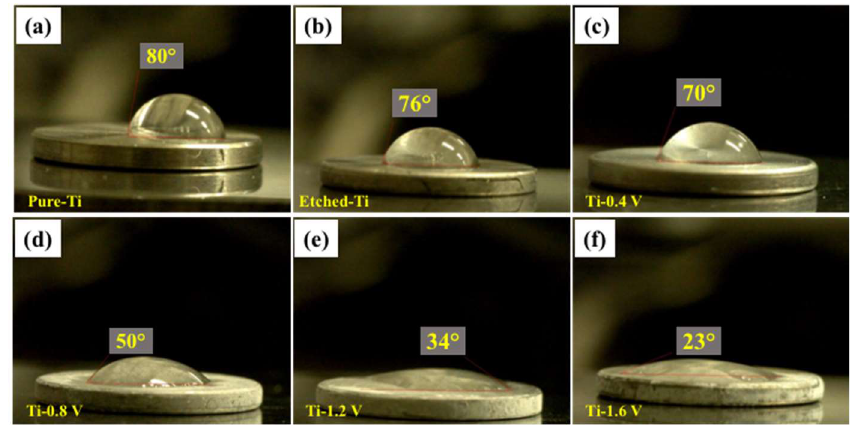
Figure 4. Contact angles on different samples: ( a ) pure Ti, ( b ) etched Ti, and deposited HAp ( c ) Ti-0.4 V, ( d ) Ti-0.8 V, ( e ) Ti-1.2 V, and ( f ) Ti-1.6 V.